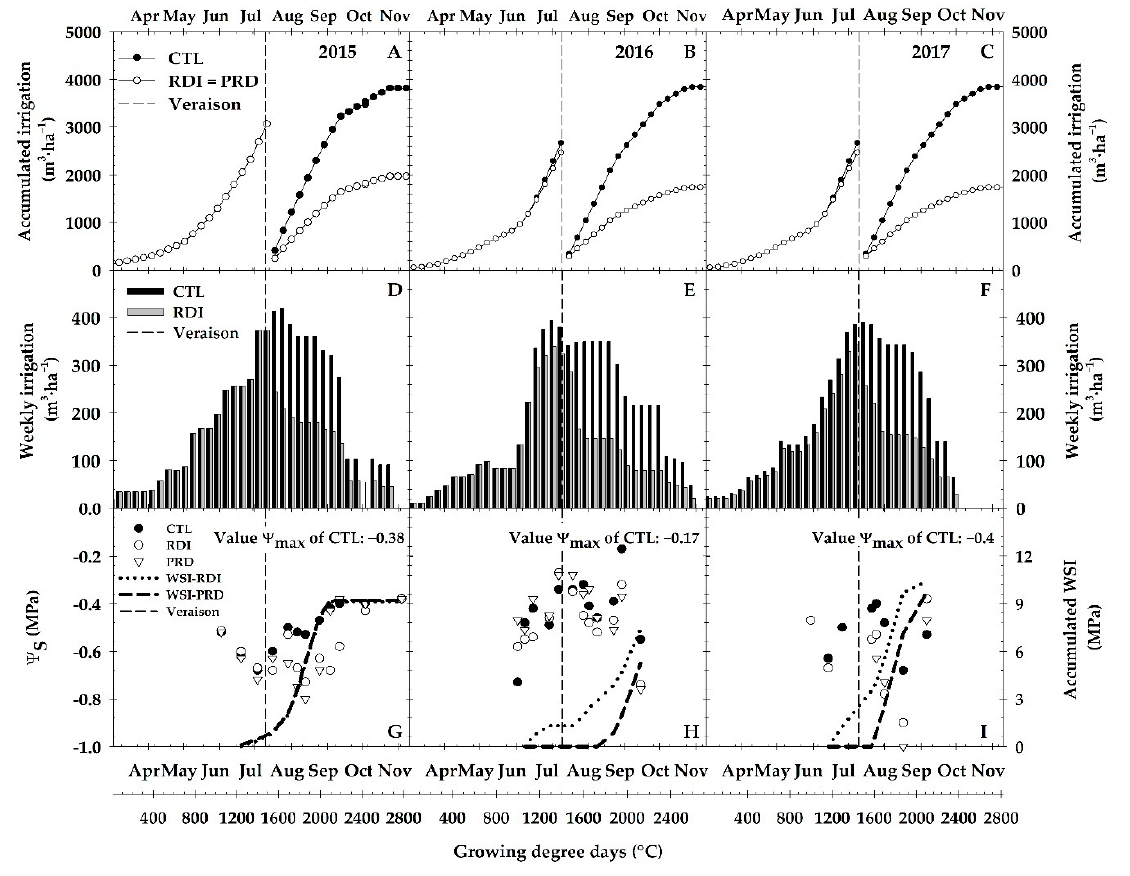
Figure 2. Seasonal cumulative water applied ( A – C ), irrigation water applied weekly ( D – F ); and stem water potential ( G – I ) and cumulative water stress integral ( G – I ) for all irrigation treatments: CTL (black circles), RDI (white circles) and PRD (white inverted triangles) during the three years assayed (2015–2017). The vertical dash line indicates the start of the post-veraison